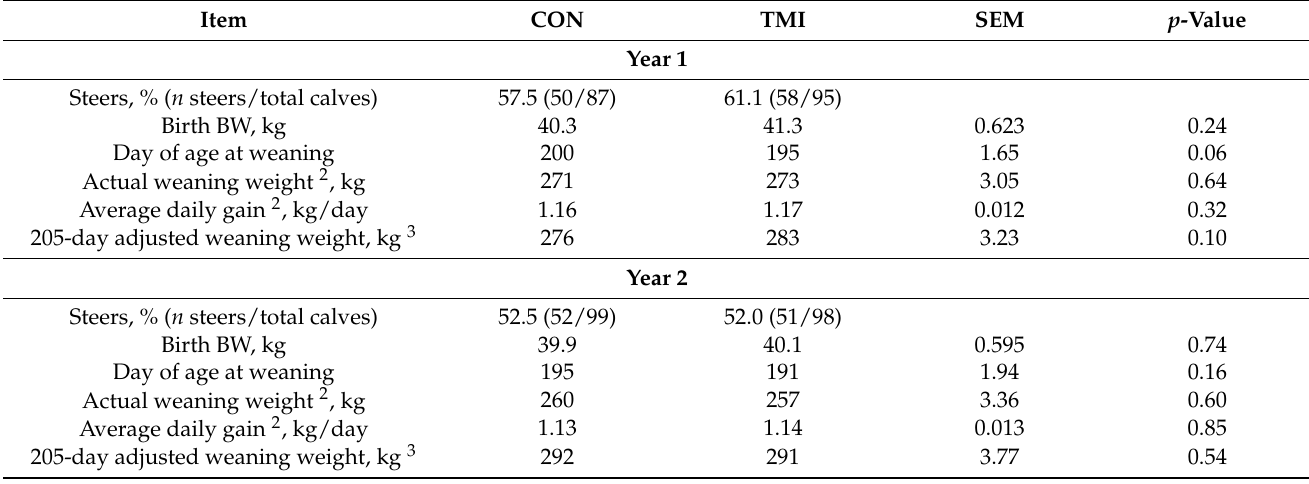
Table 6. Effect of trace mineral injection (TMI) of dams and their calves 1 vs. no injection (CON) on calf